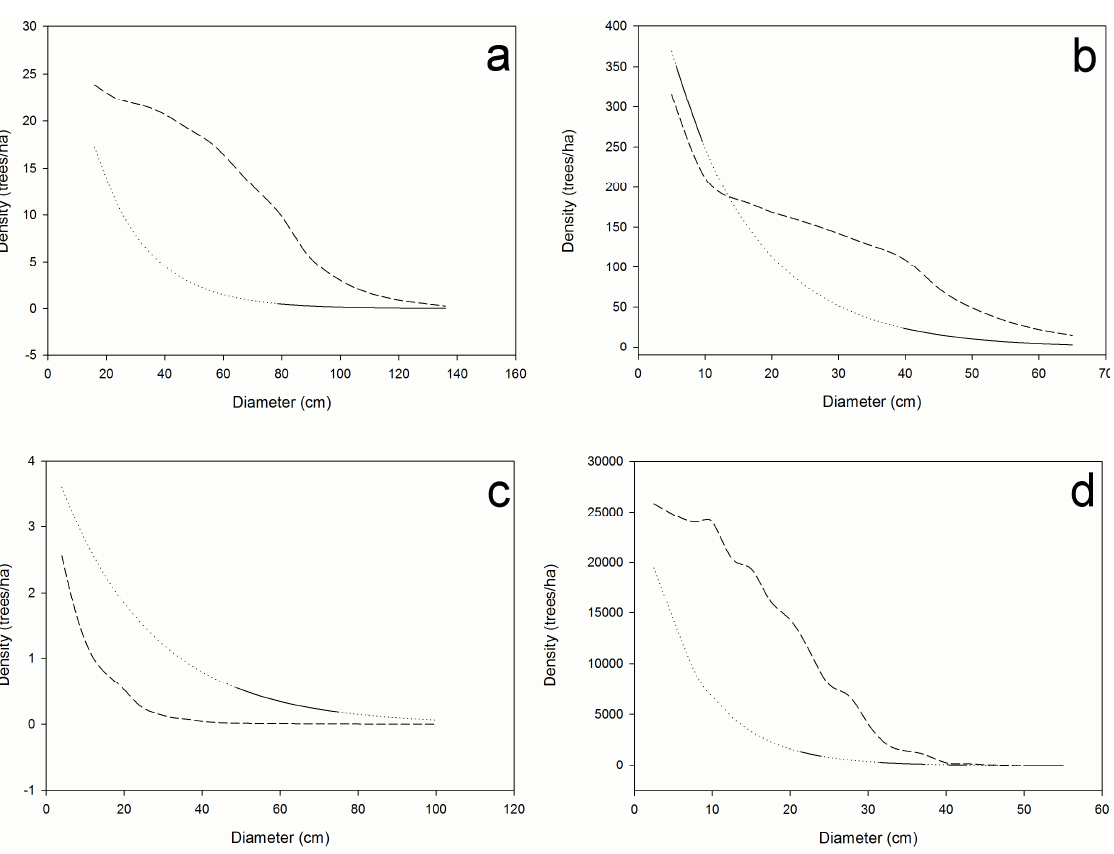
Figure 3. Calculated distributions illustrating the impact of currently observed mortality on sustainability of ( a ) Pinus ponderosa (PNW + IM), ( b ) Nothofagus solandri (NZ), ( c ) Pinus lambertiana (SN), and ( d ) Fagus grandifolia (AFP); lack of congruence of control ( ⎯ ) and projected (- - -) size class structures indicates that the observed mortalities will significantly impact forest structure; diameter classes with significant differences between observed and expected dead trees are shown as dotted lines; dashed line segments above or below the solid/dotted line indicate insufficient or excessive mortality, respectively; future diameter distributions hold ingrowth, recruitment, and mortality